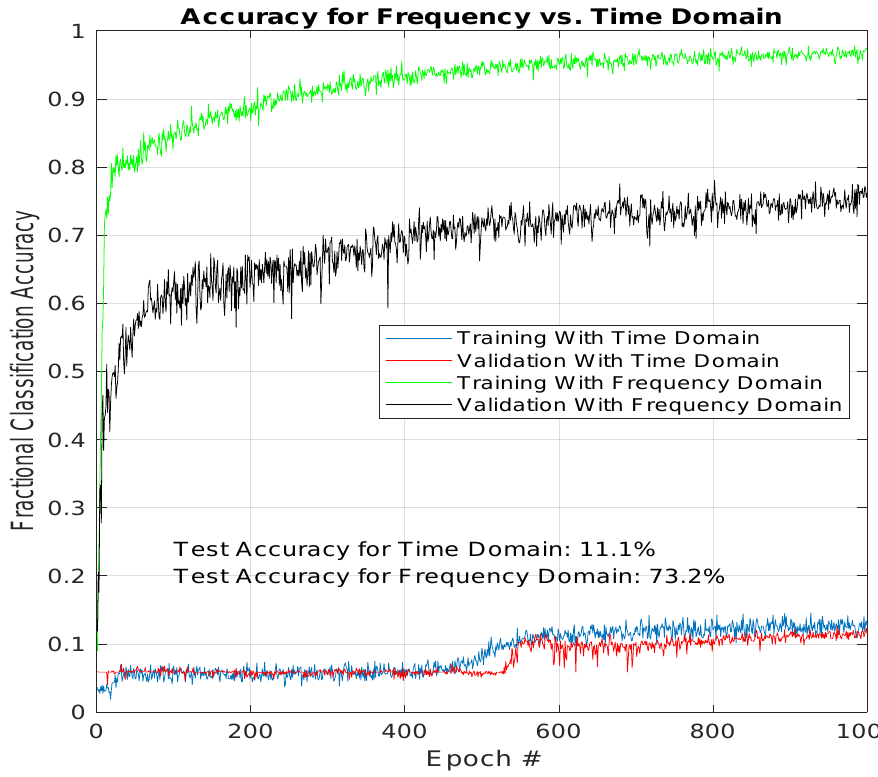
Figure 3. Classification accuracy vs. training epoch with 15 × noise